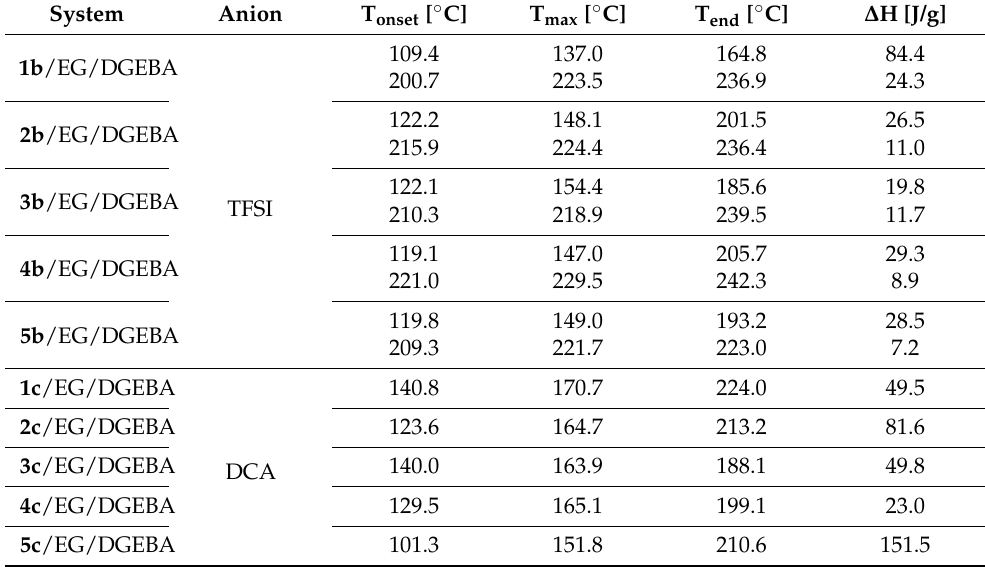
Table 3. Thermal properties of the curing